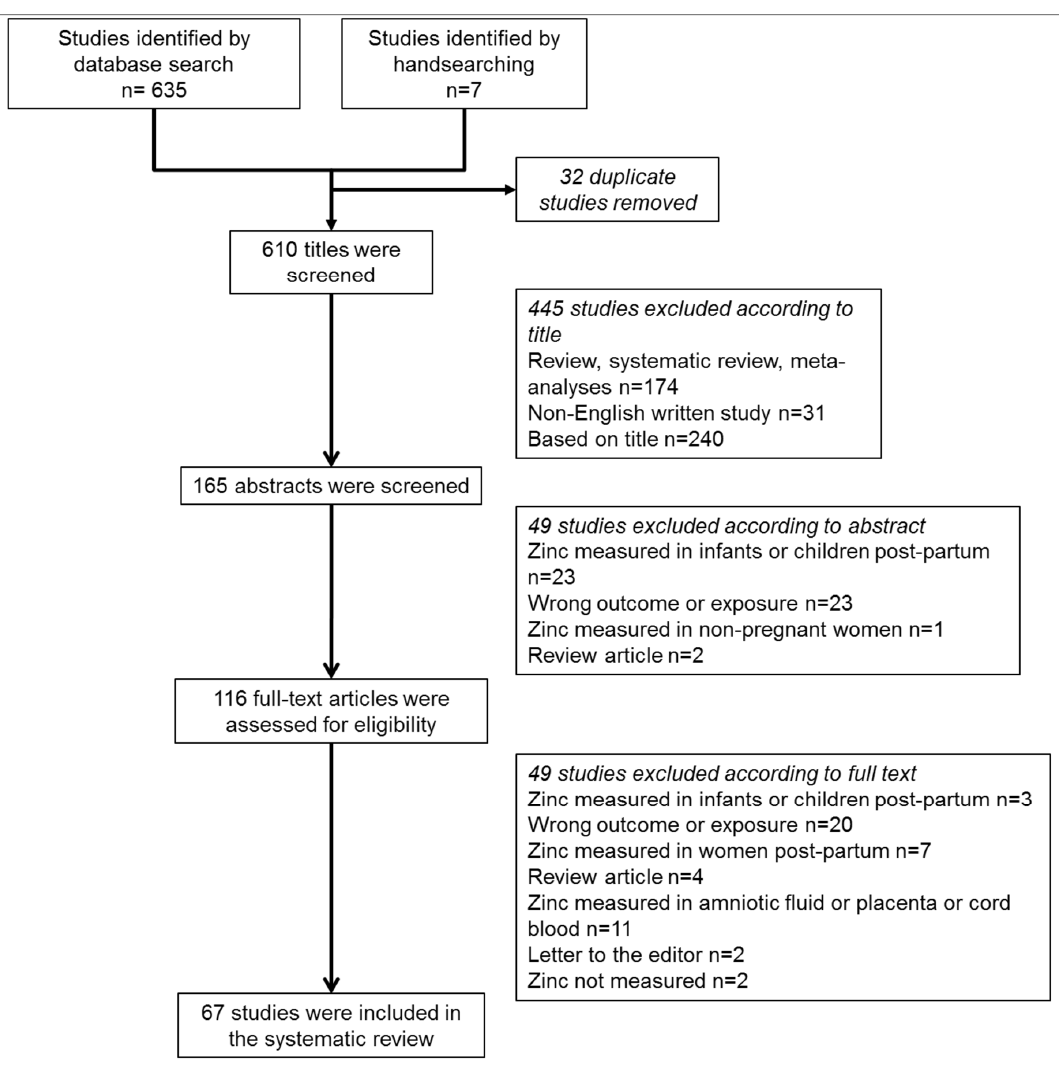
Figure 1. Flow diagram of the search strategy used in this review including the relevant number of papers at each point.